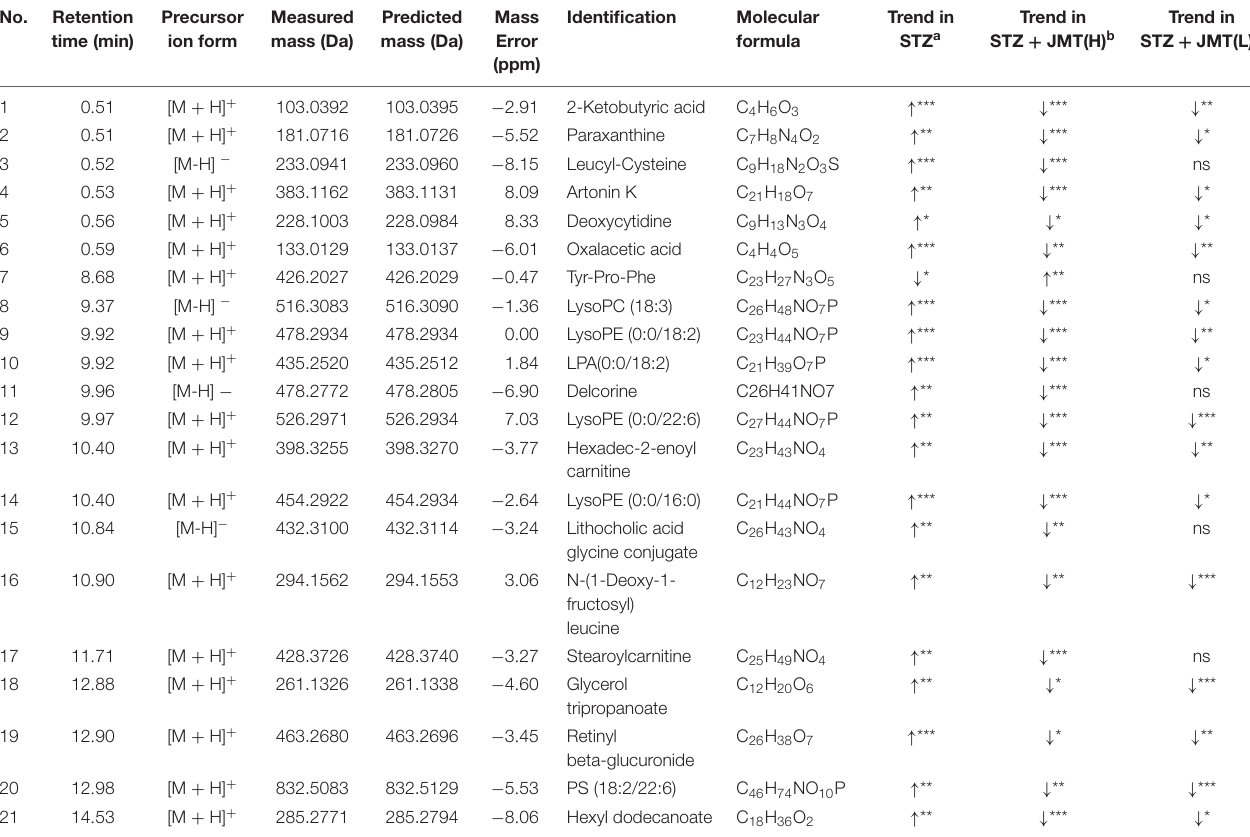
TABLE 1 | 21 identified potential biomarkers regulated by Jin-Mai-Tong (JMT) decoction. No. Retention time